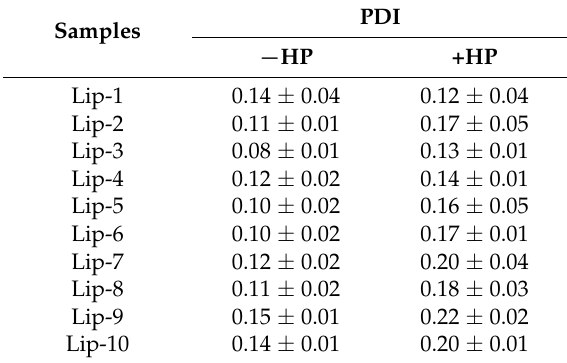
Table 2. Polydispersity index (PDI) of bare liposomal formulations and after 1-h incubation with HP.